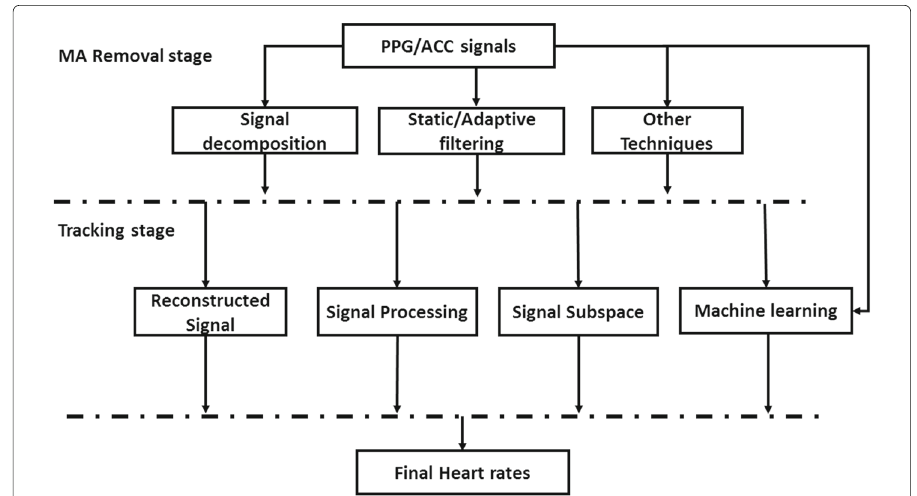
Fig. 4 A general system for heart rate estimation and